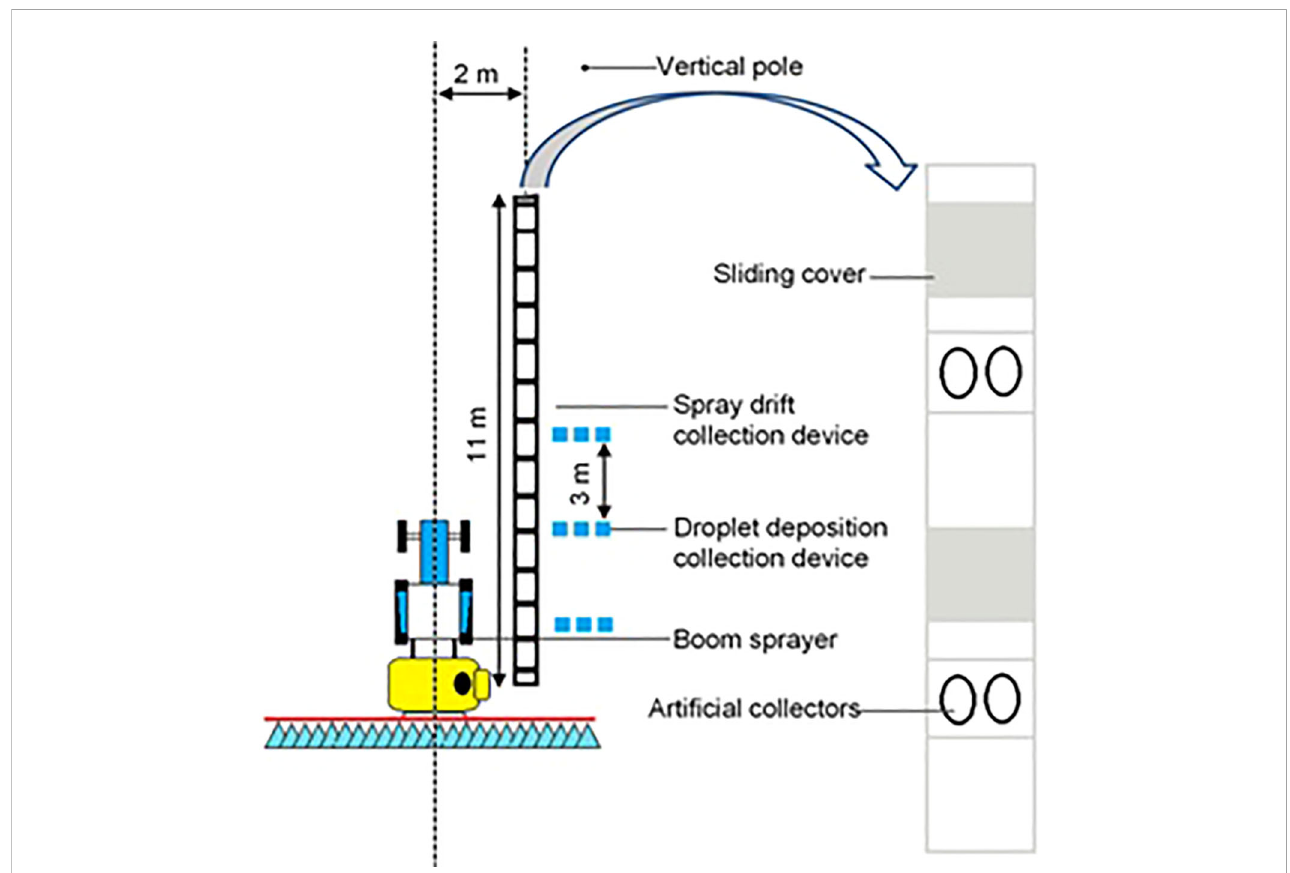
FIGURE 1 Test bench to assess potential spray drift from horizontal boom